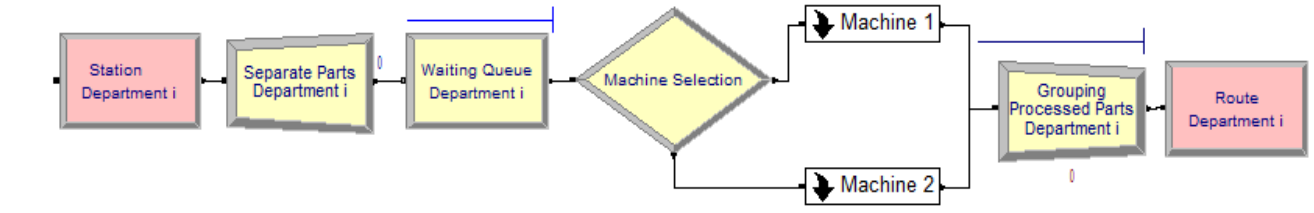
Figure 3. Simulation part model related to department “i”.